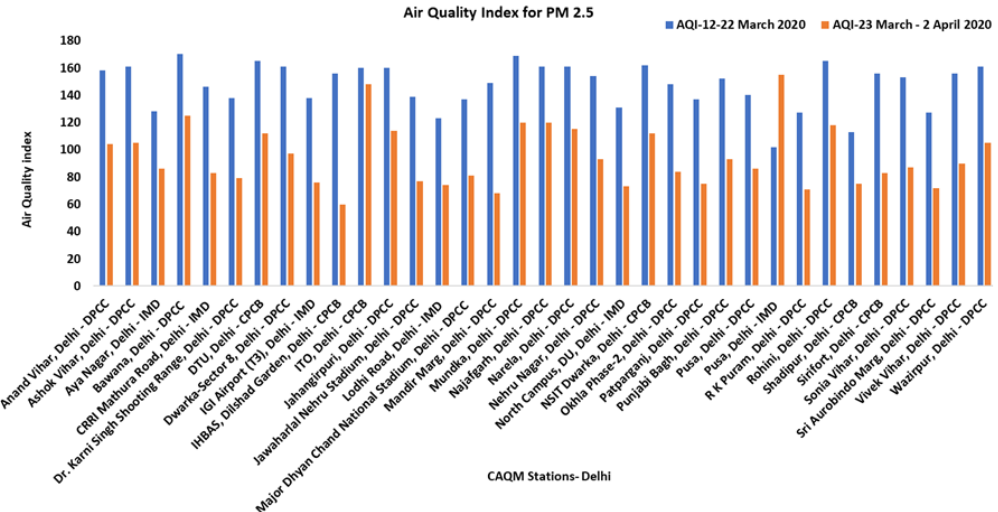
Figure 8. Comparison plot of AQI for PM 2.5 between the pre- and during-lockdown periods. On comparing the districts-wise AQI for PM 2.5 (Table 4), it was found that the maxi- mum reduction of mean AQI was in the case of Shahdara district, i.e., from 154 to 83 (46%).